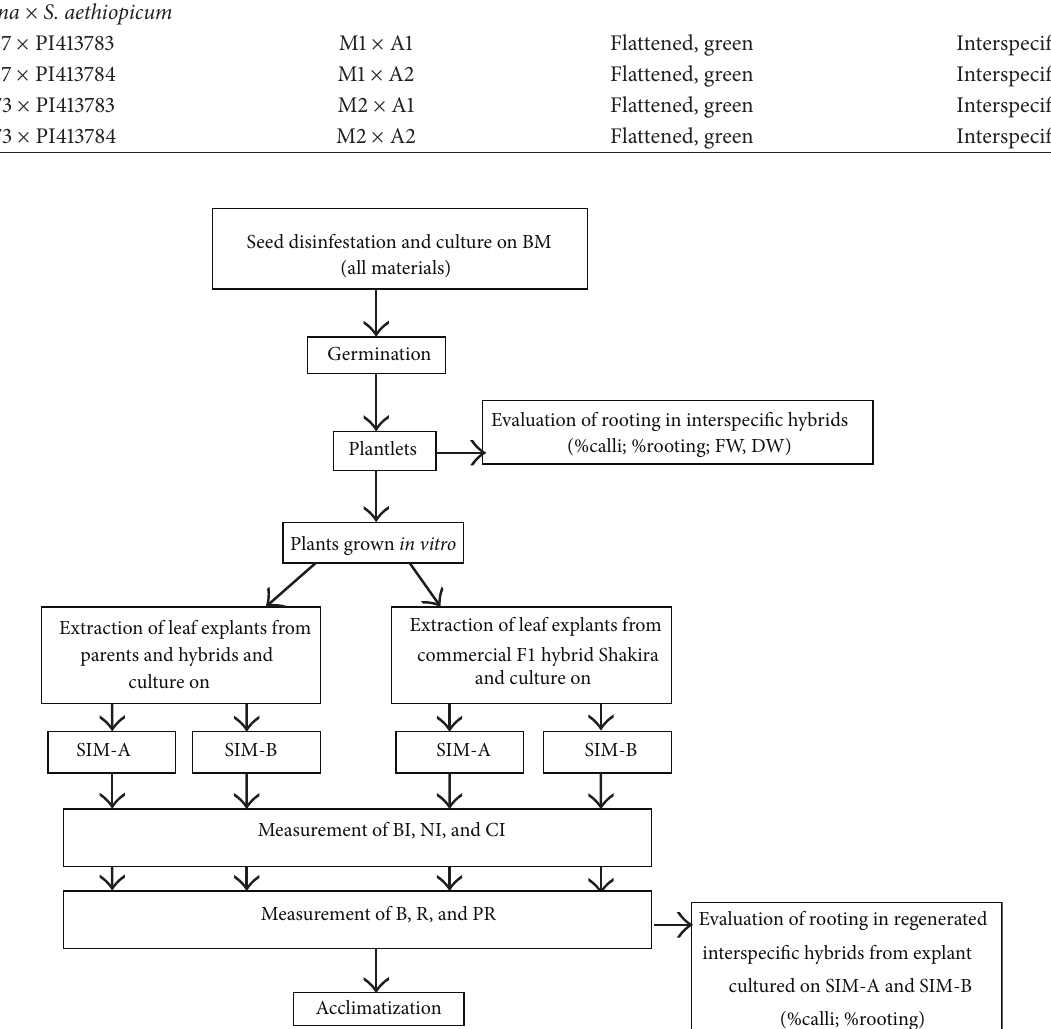
Figure 1: Scheme of the procedure followed for the study of the organogenic response and rooting ability of the S. melongena , S. aethiopicum , and interspecific hybrid